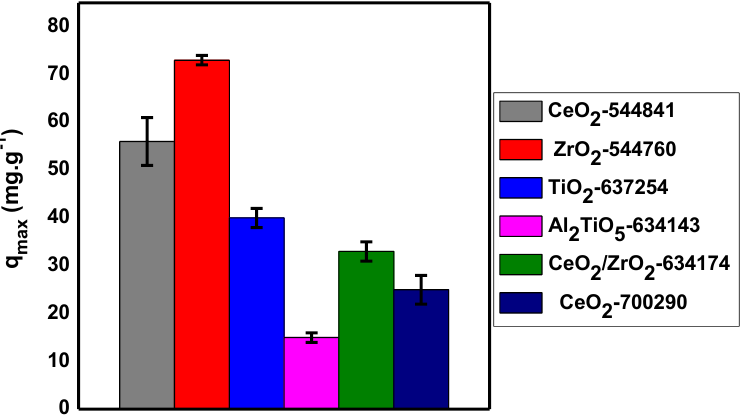
Figure 5. The maximum sorption capacity of different metal oxide NPs for CA- 99 Mo.